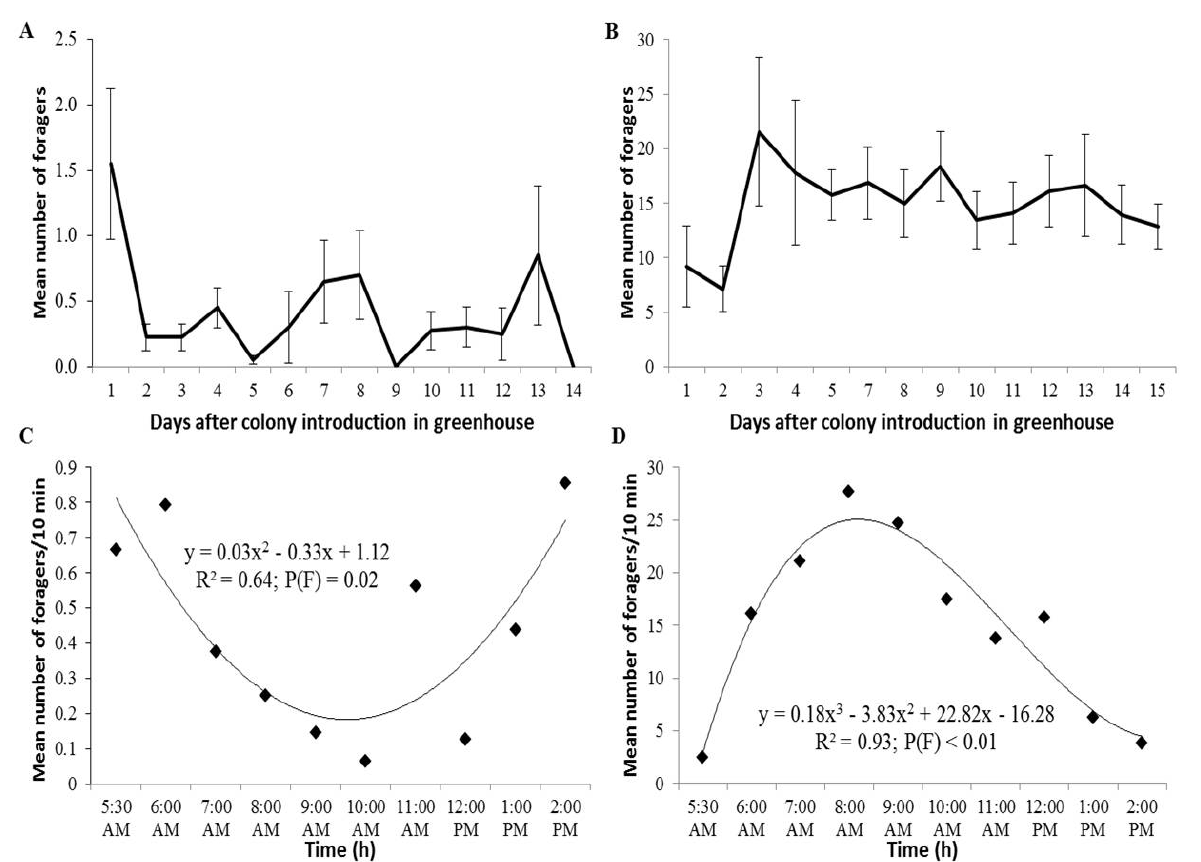
Fig 1. Outgoing flux of foragers during the anthesis of mini watermelon ( Citrullus lanatus ) flowers under a greenhouse. A - Mean daily number with standard errors of Melipona subnitida workers leaving their hives within a 10-minute period of each hour. B - Mean daily number with standard errors of Scaptotrigona sp. nov. workers leaving their hives within a 10-minute period of each hour. C - Mean hourly number of Melipona subnitida workers leaving their hives within a 10-minute period of each hour. D - Mean hourly number of Scaptotrigona sp. nov. workers leaving their hives within a 10-minute period of each